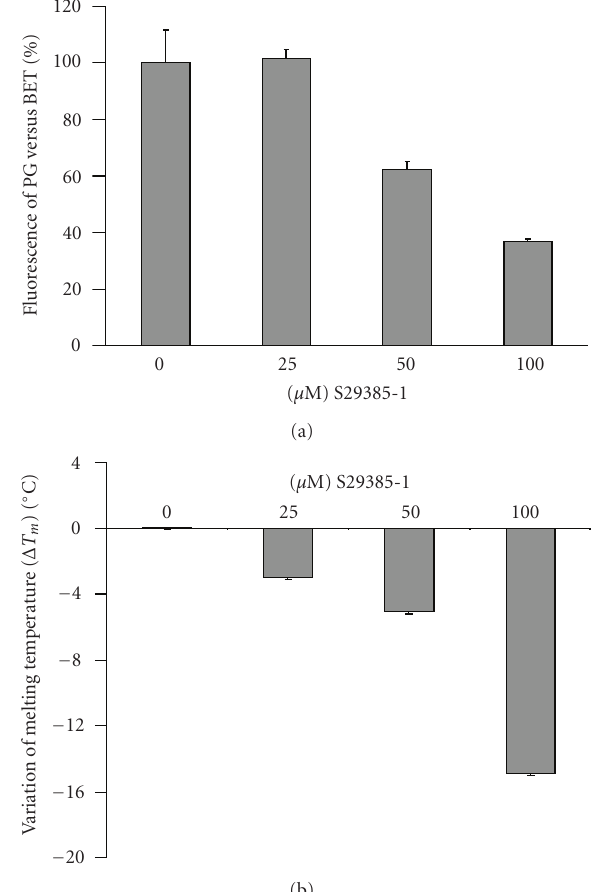
Figure 6: DNA destabilization propensities of the benzo- acronycine dicarbamate derivative S29385-1 . (a) CT-DNA was incubated with increasing concentrations of S29385-1 prior to the incubation with a mixture of e thidium bromide ( BET ) and Picogreen ( PG from Molecular Probes, Invitrogen) to quantify only double-strand DNA or both double-strand and single-stranded DNA, respectively. Results are expressed as the percentage of the peak of emission for BET versus PG . (b) Variation of the melting temperature studies of a short 24-bp double-strand oligonucleotide incubated for 24 hours alone or with increasing concentrations of S29385-1 prior to ethanol precipitation of the sample and melting temperature measurement. The results are expressed as the melting temperature for the [DNA+drug] complex minus melting temperature for DNA alone. (Details for the corresponding experimental protocols are described in [91].)